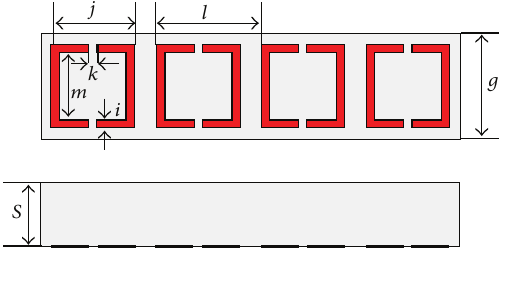
Figure 9: Geometry of LHM